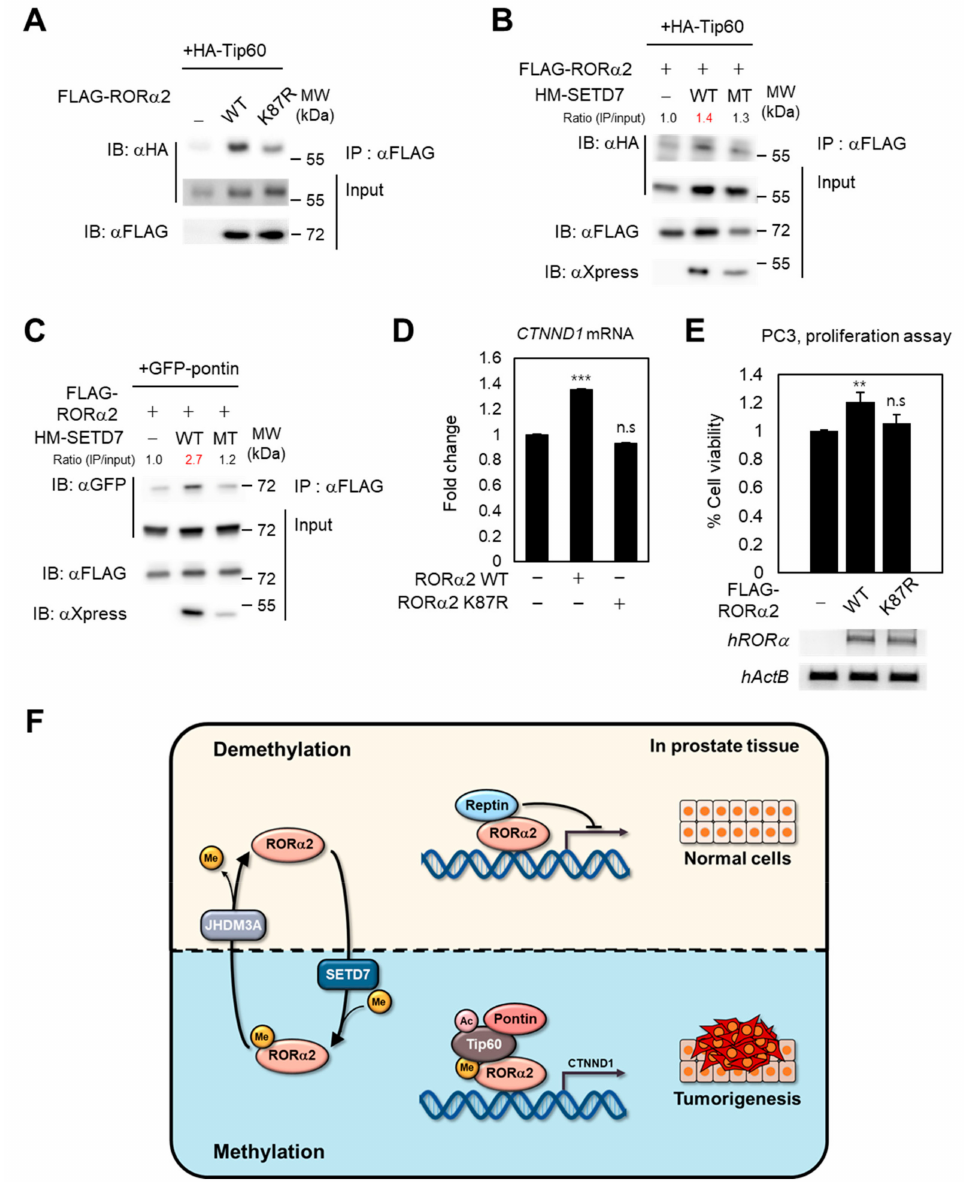
Figure 4. Tip60 coactivator interacts with ROR α 2 in a methylation-dependent manner and activates the signaling pathway downstream of ROR α 2. ( A ) Methylation of ROR α 2 induces its binding with Tip60. A binding a ffi nity assay between Tip60 and ROR α 2 WT or K87R mutant was performed. ( B , C ) Cells were transfected with Hismax-SETD7 WT or enzymatic mutant and HA-Tip60 (B) or GFP-pontin (C), and the cell extracts were immunoprecipitated with anti-FLAG antibody followed by immunoblotting against anti-HA (B) or anti-GFP (C) antibodies in the presence or absence of enzymatic activities of SETD7. ( D ) Quantitative RT-PCR analysis of CTNND1 transcripts was performed in 293T cells (mean ± SD, n = 3). Statistical significance was calculated by a two-tailed, unpaired t -test (** p < 0.01, *** p < 0.001, n.s = not significant). ( E ) The MTS cell proliferation assay of PC3 cells expressing ROR α 2 WT or ROR α 2 K87R. MTS absorbance was determined at 490 nm. Overexpressed levels of FLAG–ROR α 2 WT or ROR α 2 K87R were confirmed by RT-PCR (bottom). ( F ) Schematic model of activation of ROR α 2 target genes by SETD7-dependent methylation of ROR α